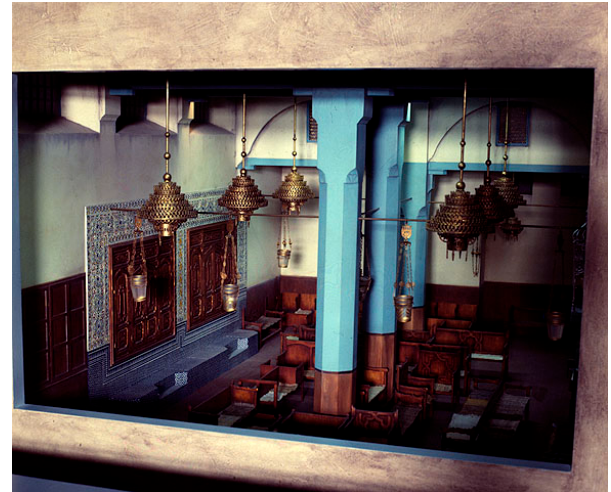
Figure 11. A model of the Ibn Danan synagogue of Fez, Morocco, at the synagogue exhibition at the Museum of the Jewish People at Beit Hatfutsot (photo: The Oster Center for Visual Documentation, Beit Hatfutsot)